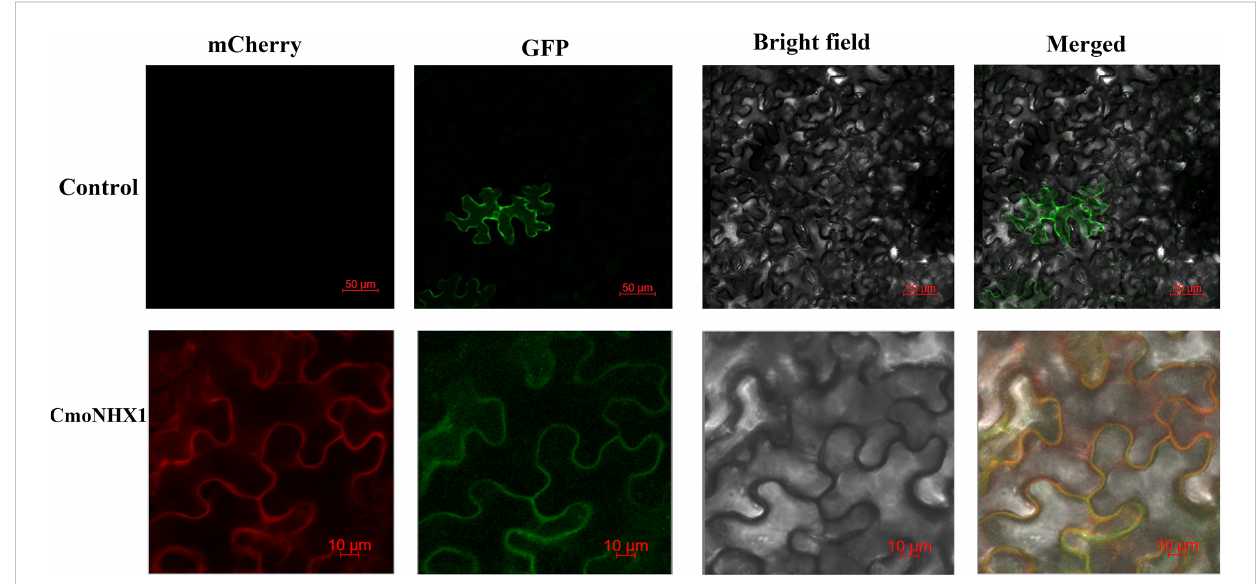
FIGURE 9 Subcellular localization of CmoNHX1 . Transient expression of PRI101-GFP -CmoNHX1 in tobacco leaf cells. The PRI101-GFP construct was used as the control. Control, PRI101-GFP; CmoNHX1 , PRI101-GFP- CmoNHX1 ; mCherry, membrane marker: pm-rbCD3-1008; GFP, green fl uorescence of CmoNHX1 ; Bright fi eld, bright fi eld images of tobacco leaf cells; Merged, overlay of bright fi eld, green fl uorescence and red fl uorescence images; Bars 50/10